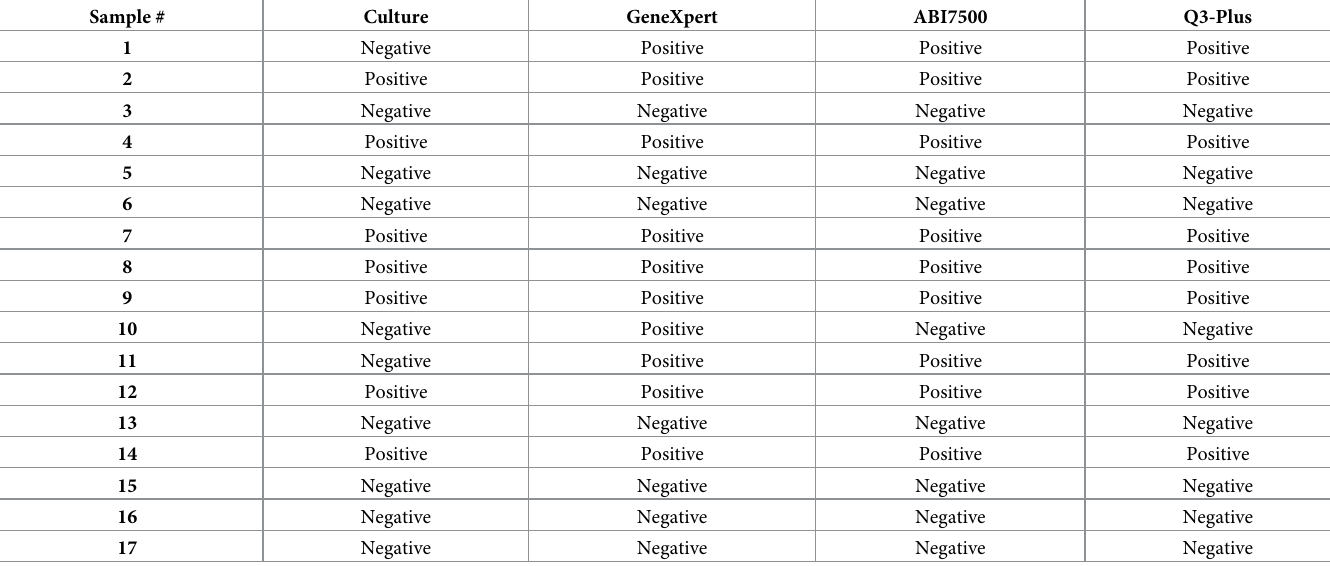
Table 6. Comparison of detection of M . tuberculosis among different platforms.